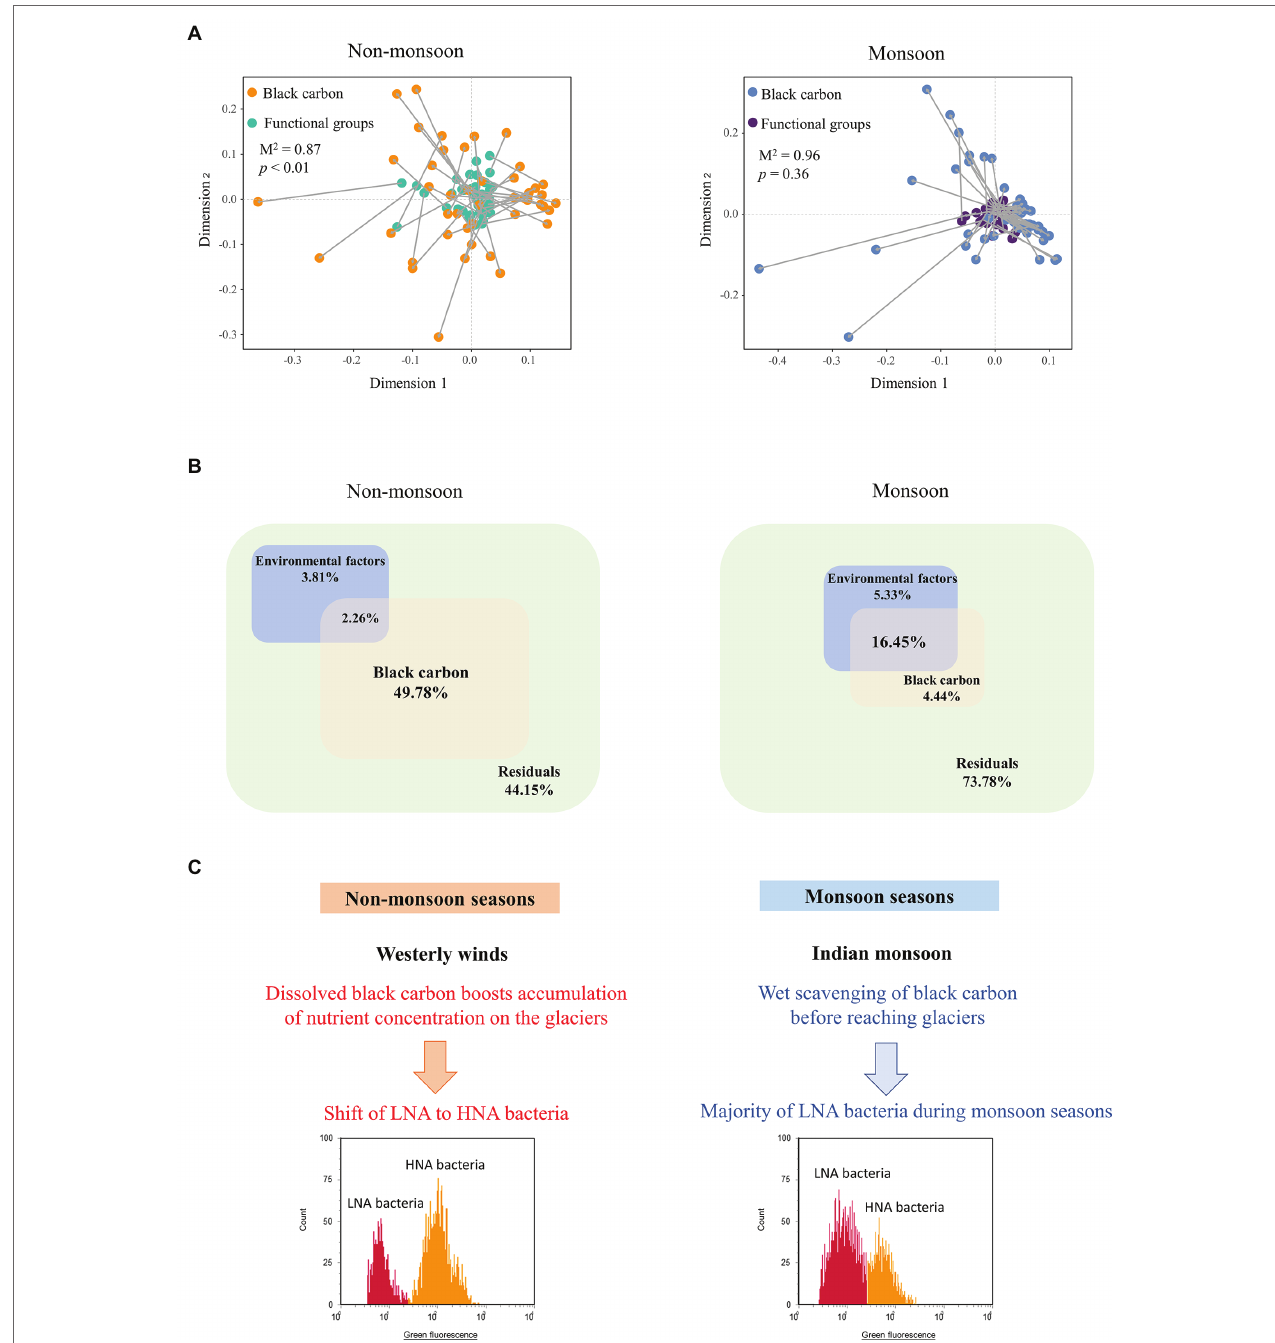
FIGURE 5 | Relationships between BC and LNA and HNA functional groups. (A) Procrustes analyses of the correlations between BC and functional groups during non-monsoon and monsoon. M 2 values represent the Procrustes sum of squares. Value of p represents the significance under 999 permutations test. (B) Variation partitioning analysis (VPA) differentiating the effect (%) of environmental factors and BC on proportion of LNA and HNA. (C) Schematic representation of HNA and LNA functional groups respond to BC under influence of Indian Monsoon.